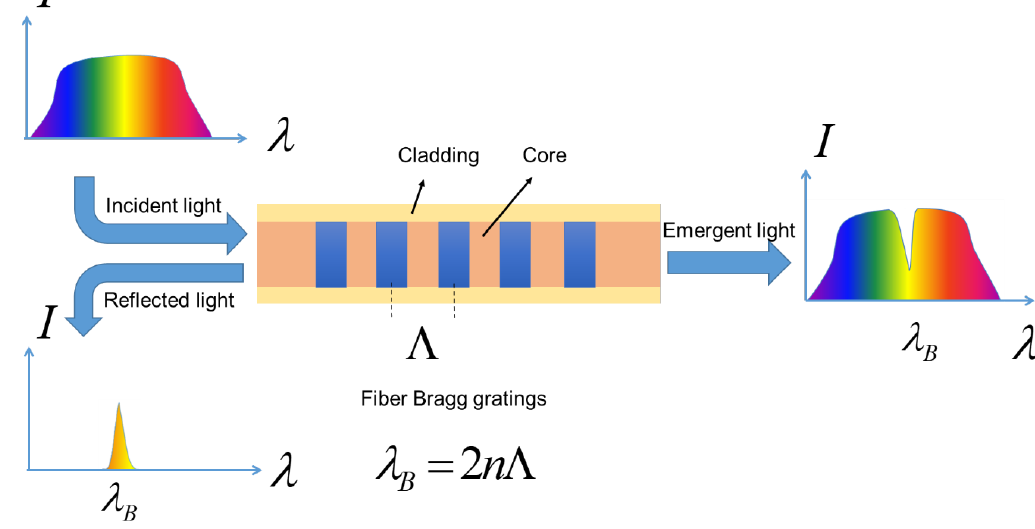
Figure 4. Schematic of Bragg gratings.